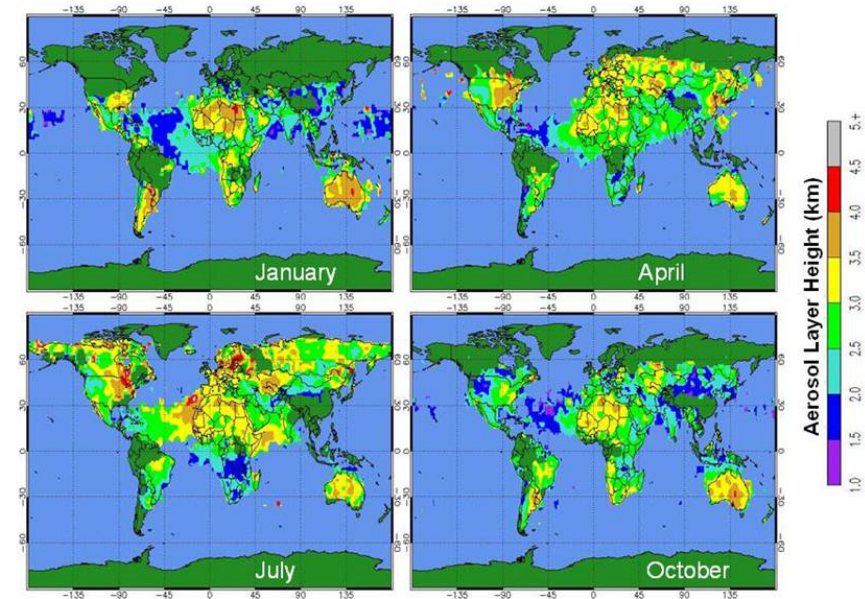
Fig. 6. Monthly average aerosol layer height.